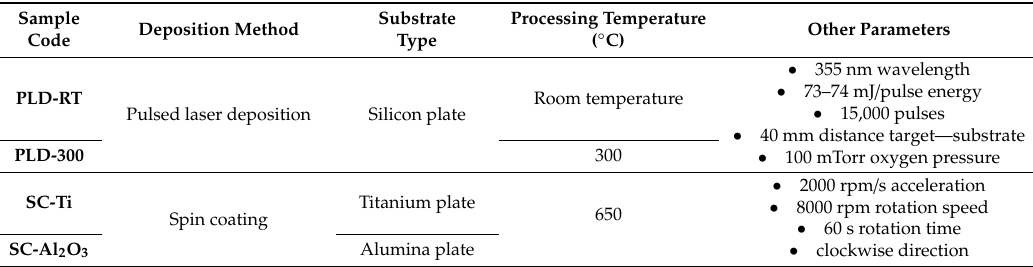
Table 2. Details of the coatings’